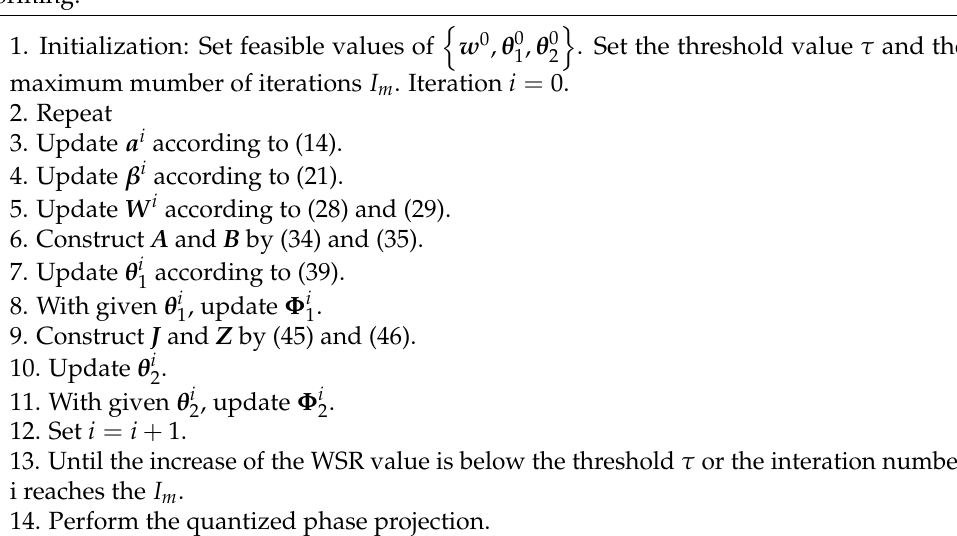
Algorithm 1 The AO Algorithm for joint design of active and cooperative passive beam- forming.